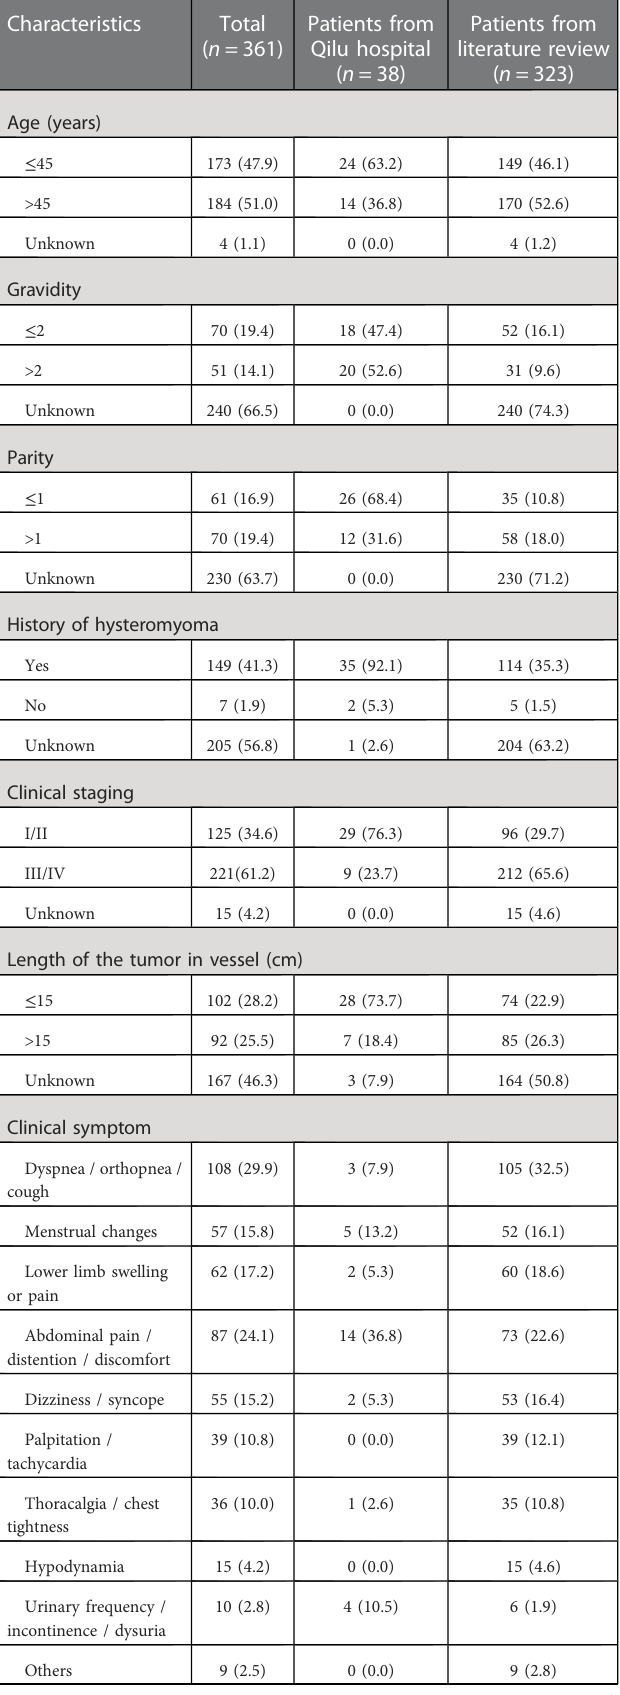
TABLE 1 Clinical characteristics of IVL patients.